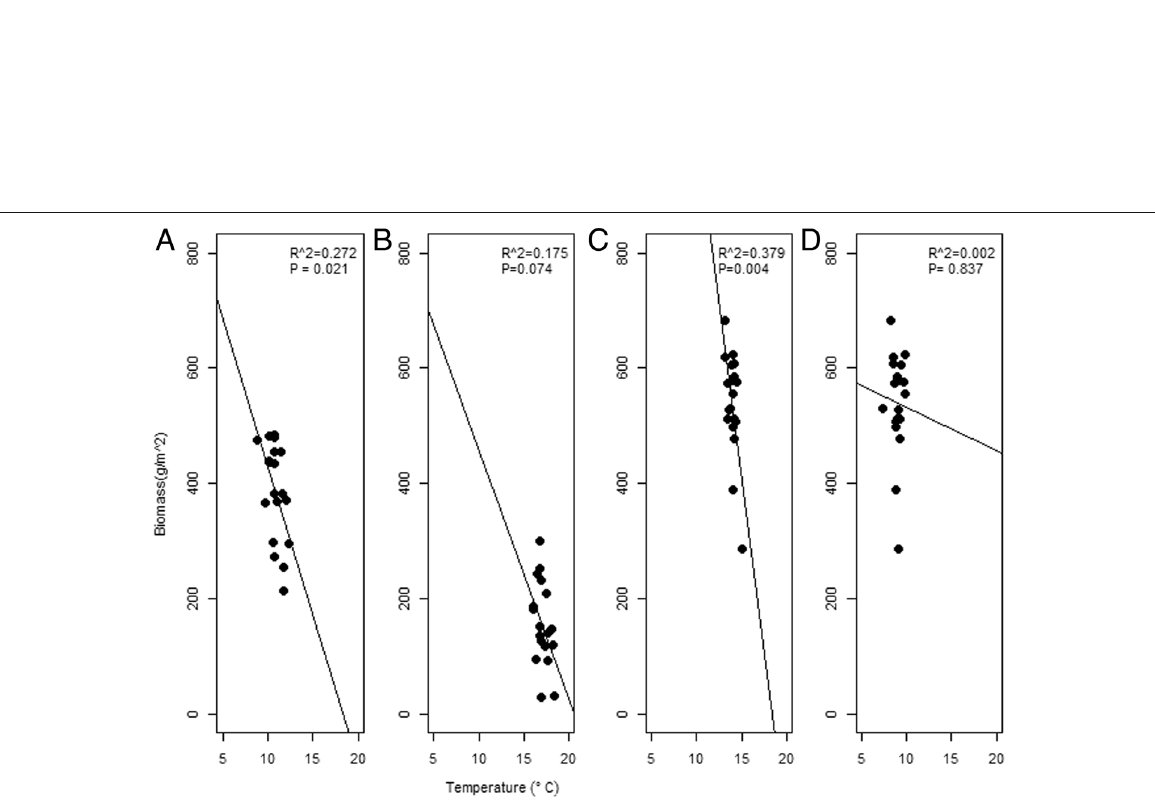
Fig. 3 Response of aboveground biomass productivity to temperature variability for the study period 1997 – 2015. Relationships of aboveground biomass in June with growing season (March – June) temperature ( a ), biomass in September with growing season (June – September) temperature ( b ), annual biomass with growing season (March – September) temperature ( c ), and annual biomass with annual mean temperature ( d